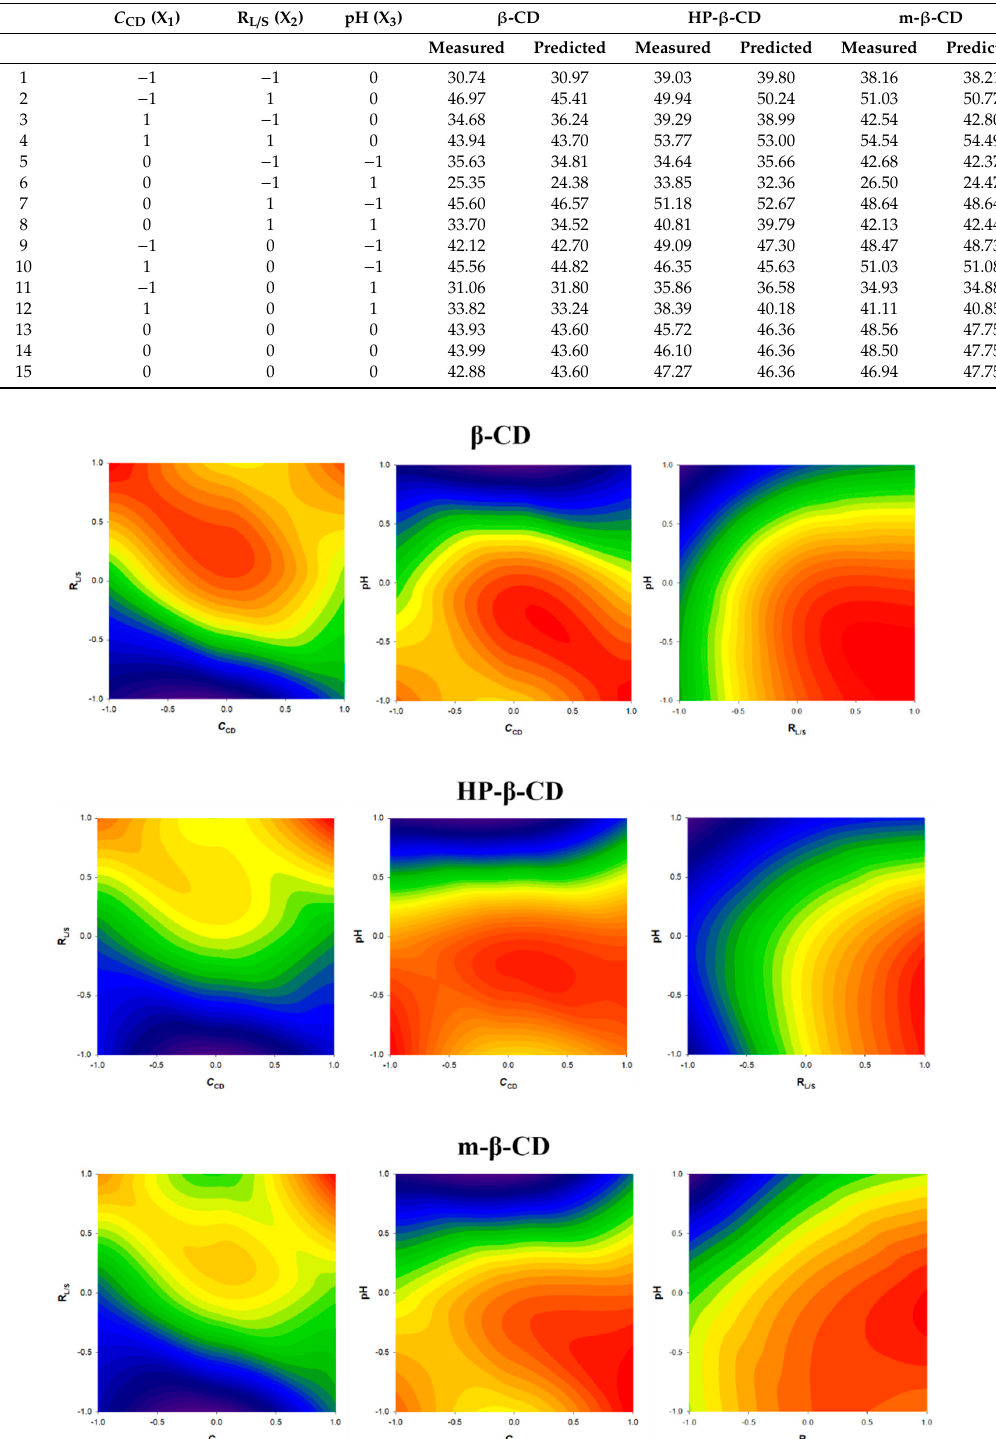
Figure 2. Contour graphs presenting the effect of simultaneous variation of independent variables on the response. Assignments: β -CD, β -cyclodextrin; HP- β -CD, hydroxypropyl β -cyclodextrin; m- β -CD, methyl β -cyclodextrin.